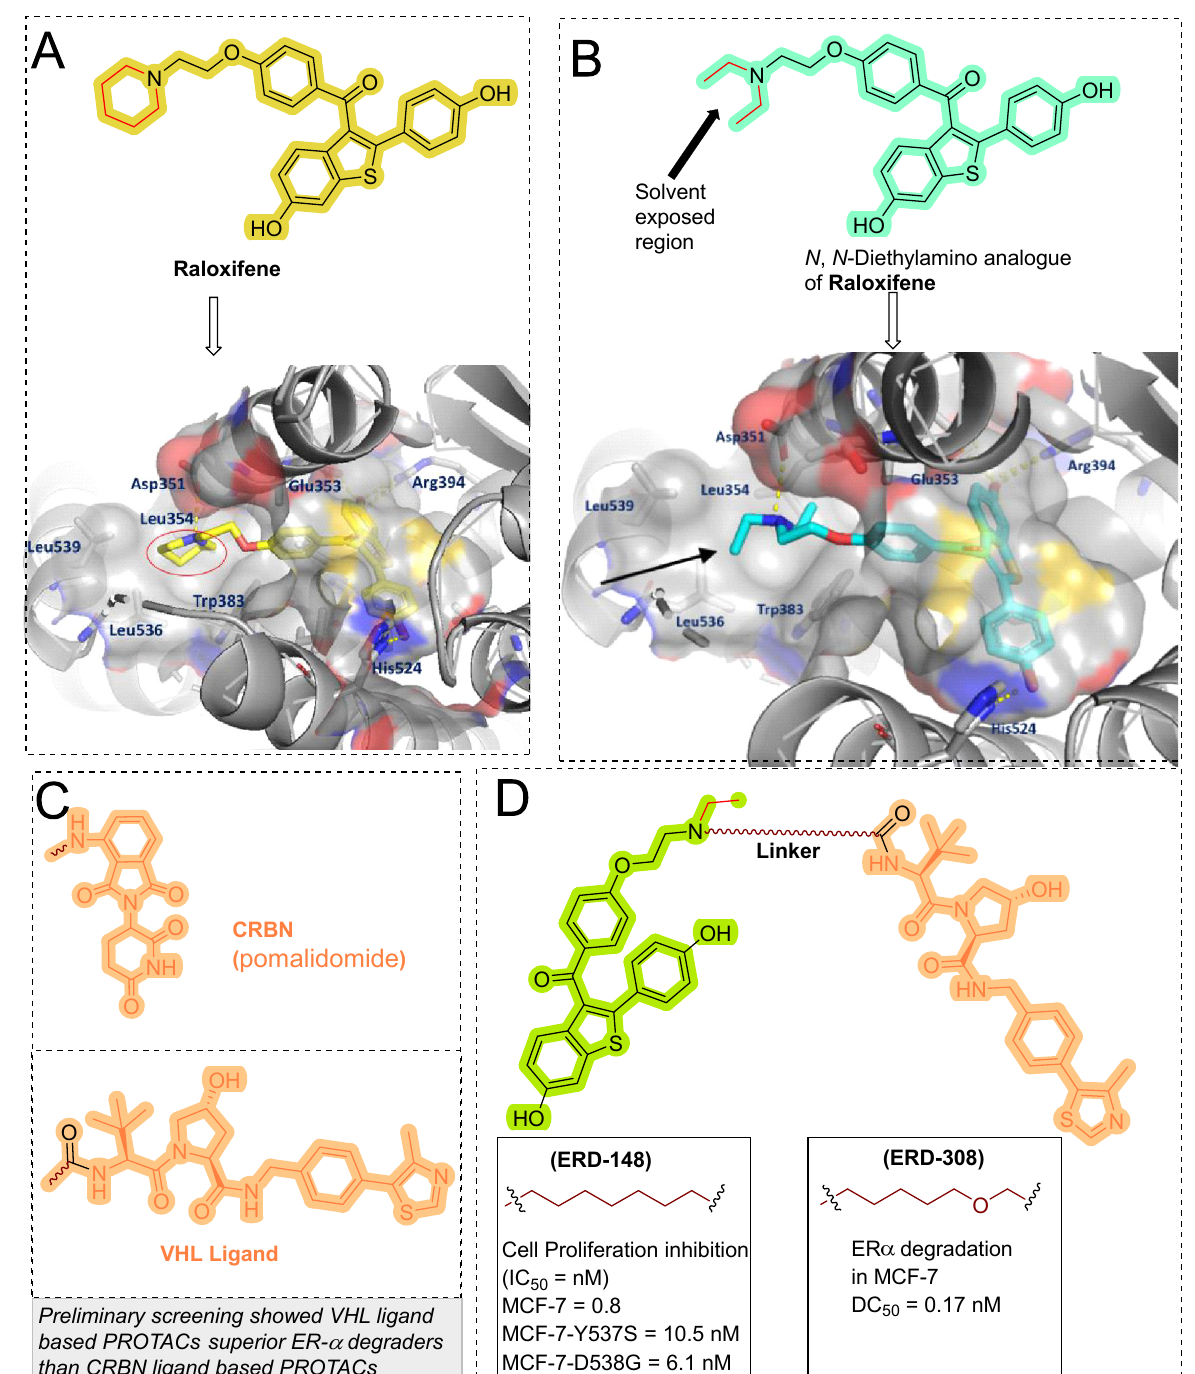
Figure 9. ( A ) Retrieving the conformational biding of raloxifene with ER- α (PDB 1ERR). ( B ) Pre- dicted conformational binding of N, N-Diethylamino analog of Raloxifene with ER- α . ( C ) Molecular structure of CRBN and VHL ligand. ( D ) VHL-based PROTACs ( ERD-308 , ERD-148 ). conformational binding of N, N-Diethylamino analog of Raloxifene with ER- structure of CRBN and VHL ligand. ( D ) VHL-based PROTACs ( ERD-308 , ERD-148